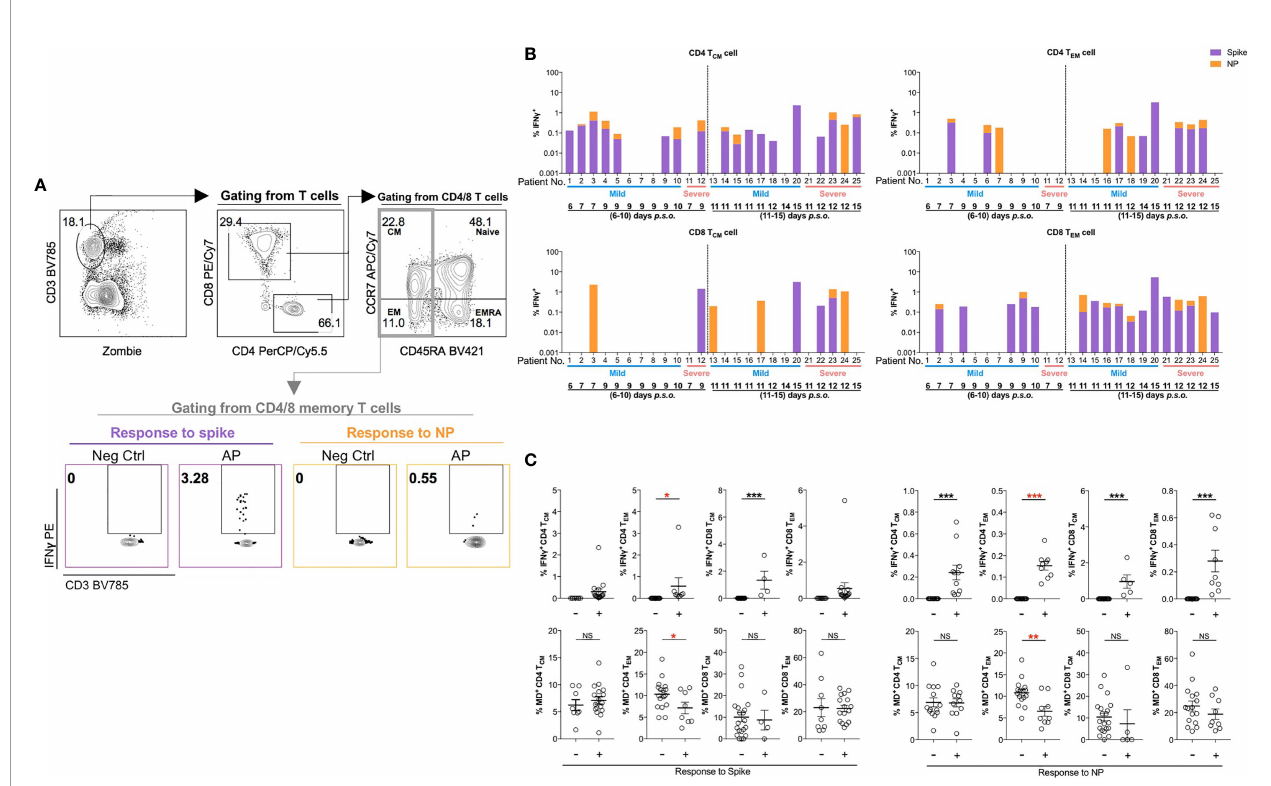
FIGURE 6 | Patients with poor SARS-CoV-2-speci fi c responses in effector memory CD4 T cells show signi fi cantly higher MD + proportion. In order to understand the relationship between cells with mitochondrial dysfunction (MD + ) and SARS-CoV-2-speci fi c T-cell responses in COVID-19 patients, 25 SARS-CoV-2 acute patients [APs; 18 mild (M) and 7 severe (S) ones during time periods of 6 – 10 and 11 – 15 days post symptoms onset (p.s.o.)] were collected for antigen-speci fi c response assessment in at least three independent experiments. Fresh peripheral blood mononuclear cells (PBMCs) were treated with 1 µg/ml spike peptide pool or 5 µg/ml puri fi ed nucleocapsid protein (NP) peptide pool in the presence of 0.5 µg/ml anti-CD28 and anti-CD49d antibodies overnight. Brefeldin A (BFA) was added 6 h before cells were harvested for FACS analysis on intracellular IFN g level. (A) Representative plots displayed gating strategy on IFN g + cells among central memory (CM) or effector memory (EM) subsets in CD4 or CD8 T cells in response to spike or NP. (B) For these 25 patients, the percentages of IFN g + cells in CD4 T CM , CD4 T EM , CD8 T CM , or CD8 T EM cells in response to spike (in purple) or NP (in orange) were displayed in stacked bar chart. Each column represents one individual. Data represent the exact value. (C) The percentages of IFN g + cells and MD + cells in CD4 T CM , CD4 T EM , CD8 T CM , or CD8 T EM cells from these 25 patients during the time period of 6 – 15 days p.s.o. were also compared between poor responders (-) and good responders (+) speci fi c to spike or NP peptide pool. Data represent mean ± SEM. Statistics were calculated based on unpaired Student ’ s t-test. * p < 0.05, ** p < 0.01, *** p < 0.001. NS, not signi fi cantly